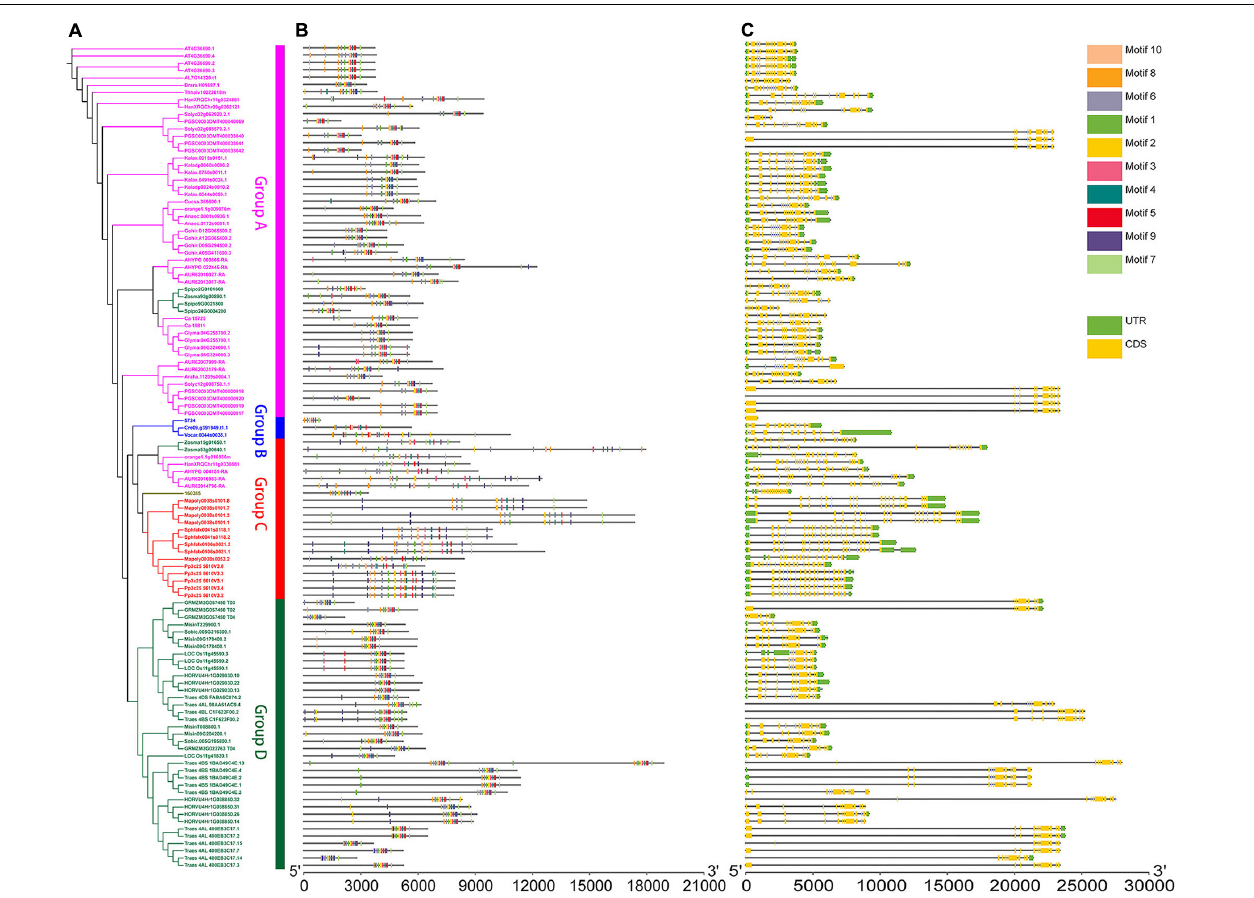
FIGURE 1 | Genomic structure organization and conserved DNA motifs amongst plant U2AF65A genes. Gene structure (A) and conserved motifs (B) of cDNA (by MEME analysis) are shown against the vertical phylogenetic tree (C)